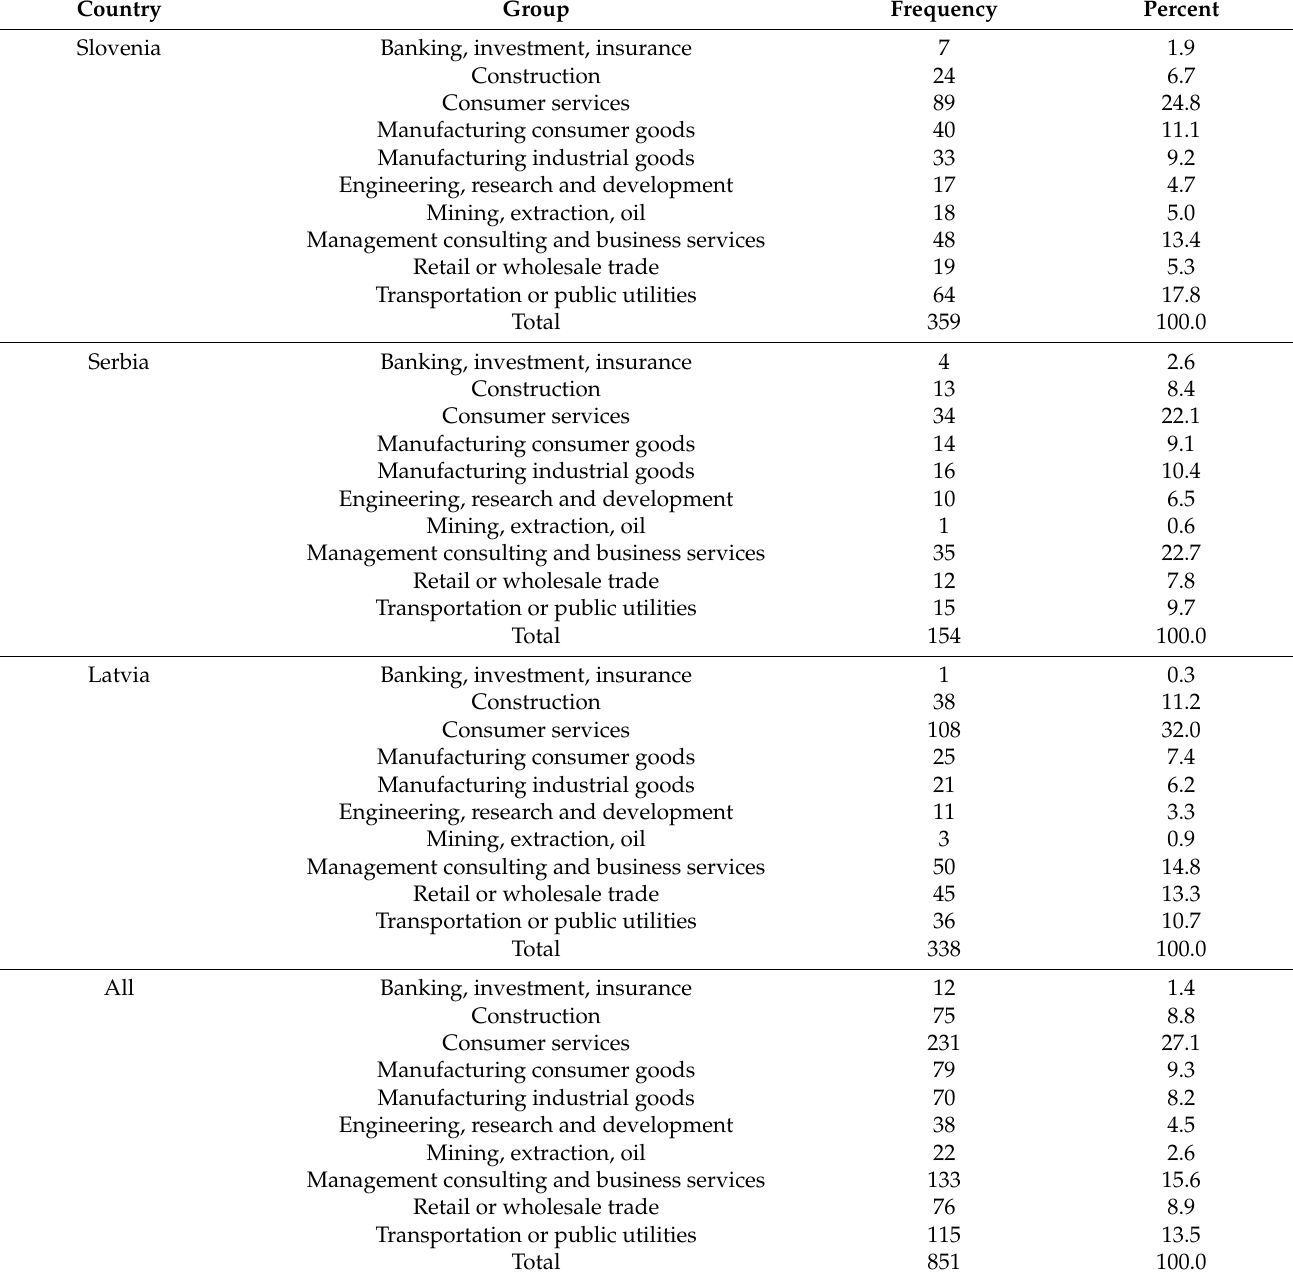
Table A7. Type of